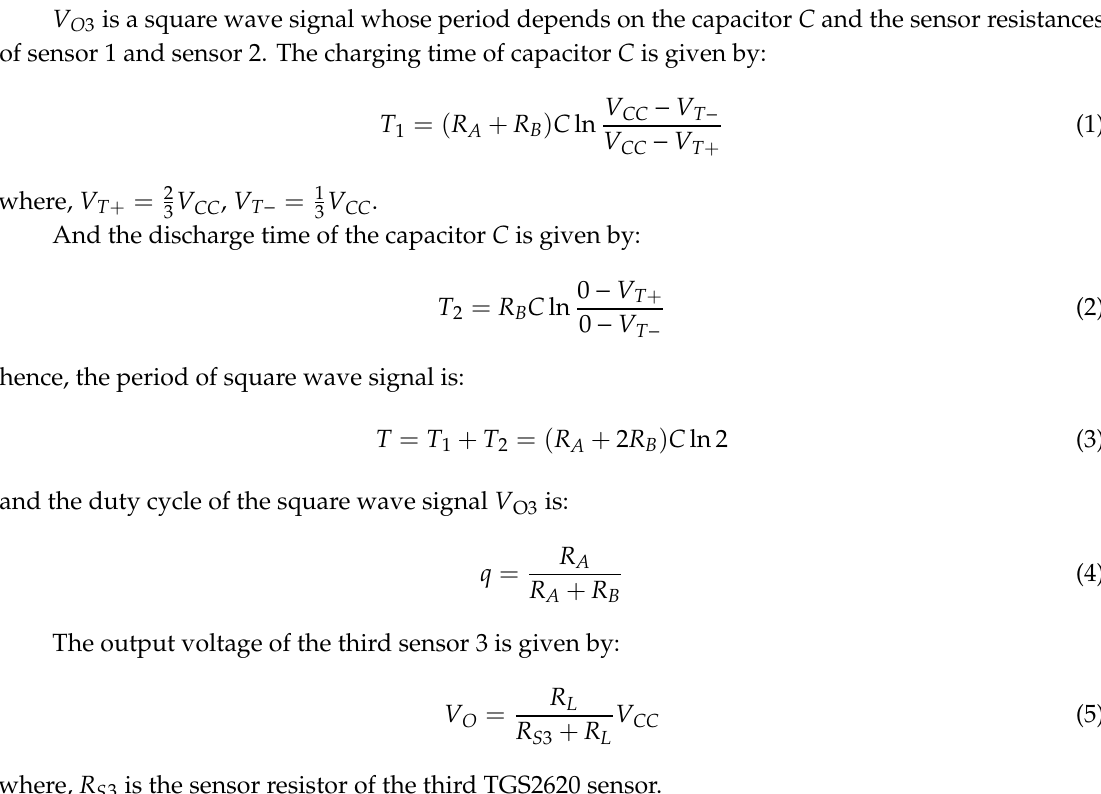
Figure 1. The measurement circuit. Sensor 1 is TGS2610, sensor 2 is TGS2610, and sensor 3 is TGS2620. V REFL and V REFH represent low and high reference voltage of heating voltage, respectively.